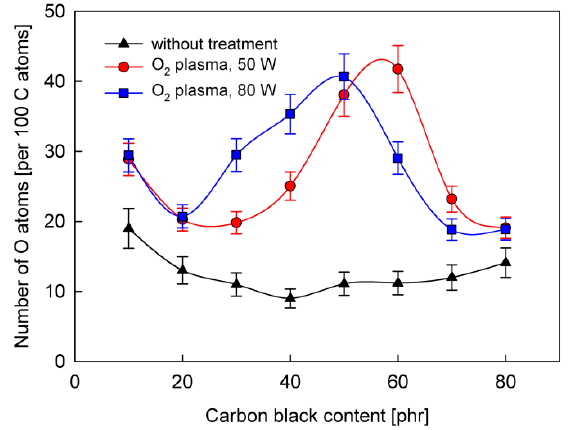
Figure 5. The concentration of oxygen atoms on the surface of SBS rubber with various carbon black content, before and after plasma treatments.